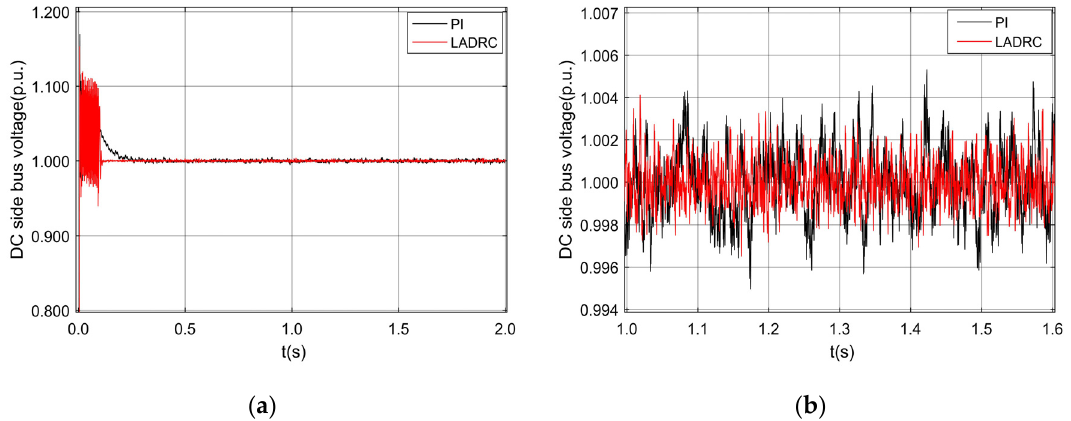
Figure 10. Comparison of voltage waveforms between two control strategies under steady-state condition ( a ) Comparison of overall voltage fluctuations ( b ) Comparison of local voltage fluctuations.